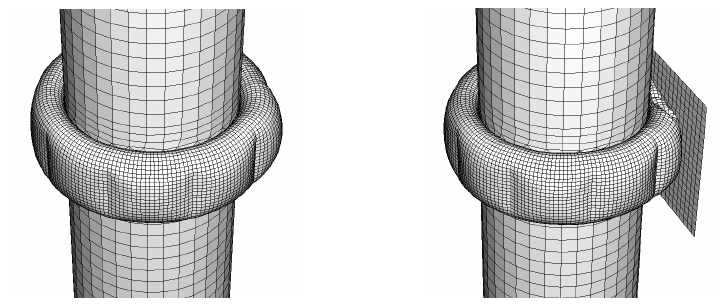
Fig. 4. Three dimensional model of collision: initial inflation and deformation during collision.